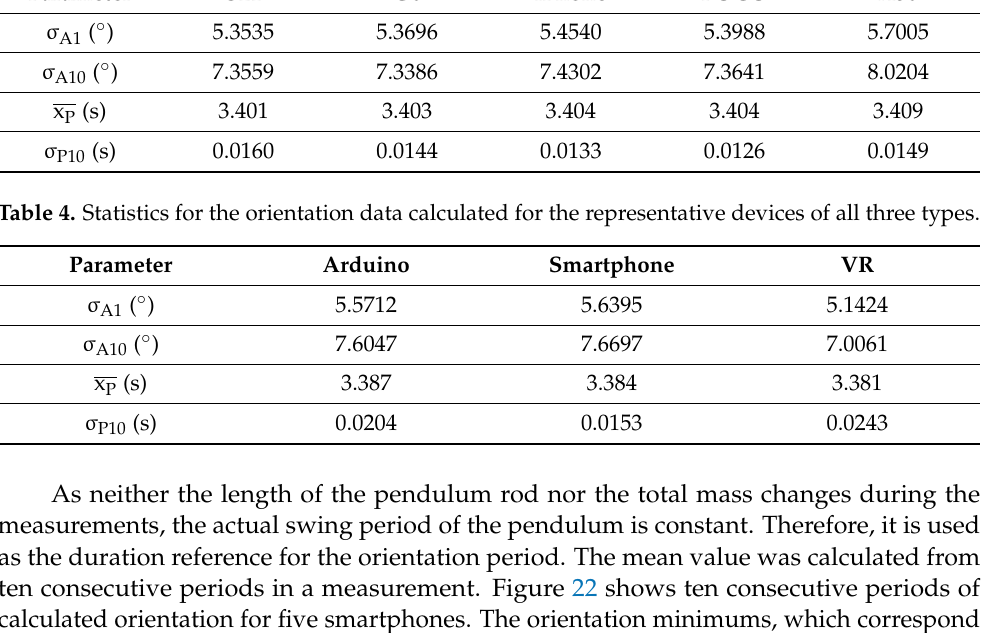
Table 2. Statistical analysis of the orientation data calculated from raw sensor data obtained from DIY devices.